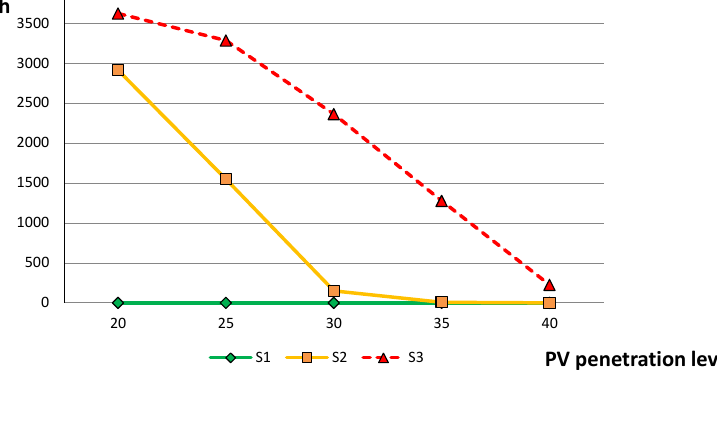
Figure 8. Hours during the year with PV-PPs in deloaded